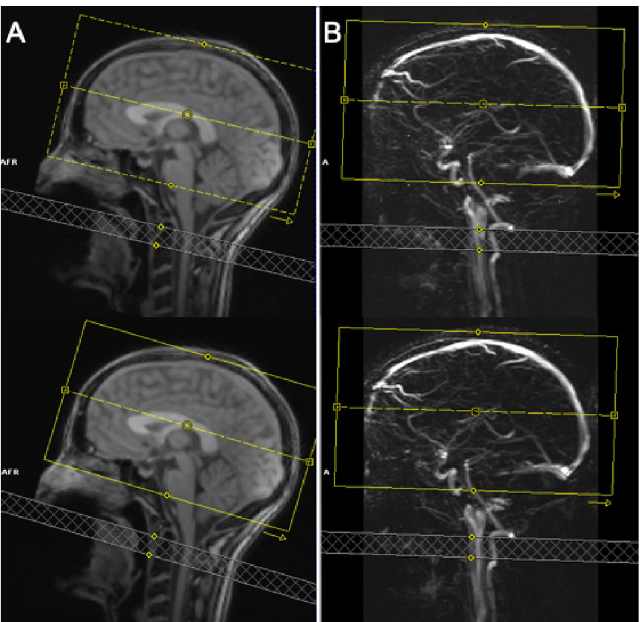
Figure 6. ( A ) Structural localizer and ( B ) time-of-flight (TOF) vessel scout for placement and alignment of the labeling volume (gray hatched) in test (top) and retest (bottom) scan to invert blood in basilar, right and left internal carotid arteries. The same gap to the image volume (yellow) was used in both measurements performed by the same